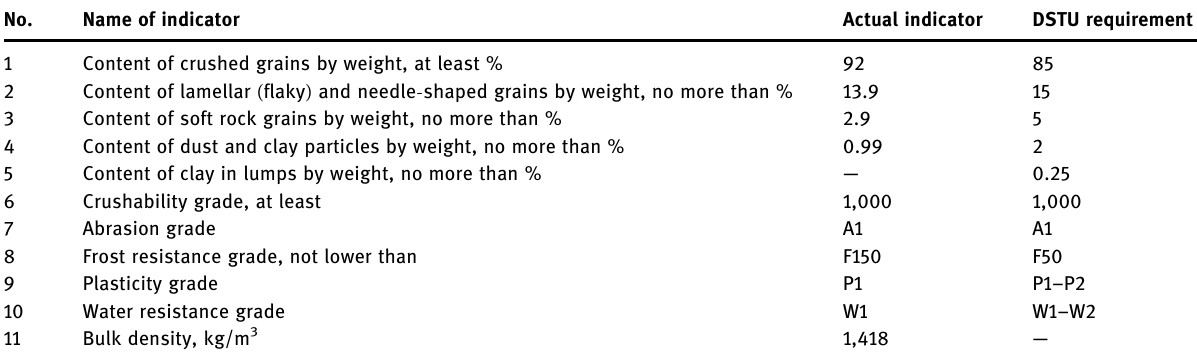
Table 5: Crushed stone properties No.